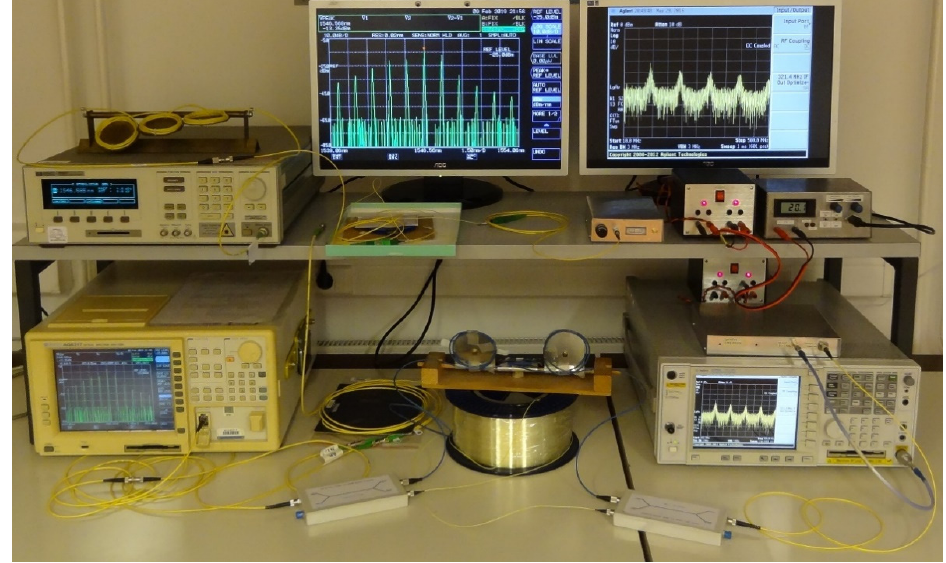
Figure 8. Experimental set-up for FP laser’s stable-locking regime